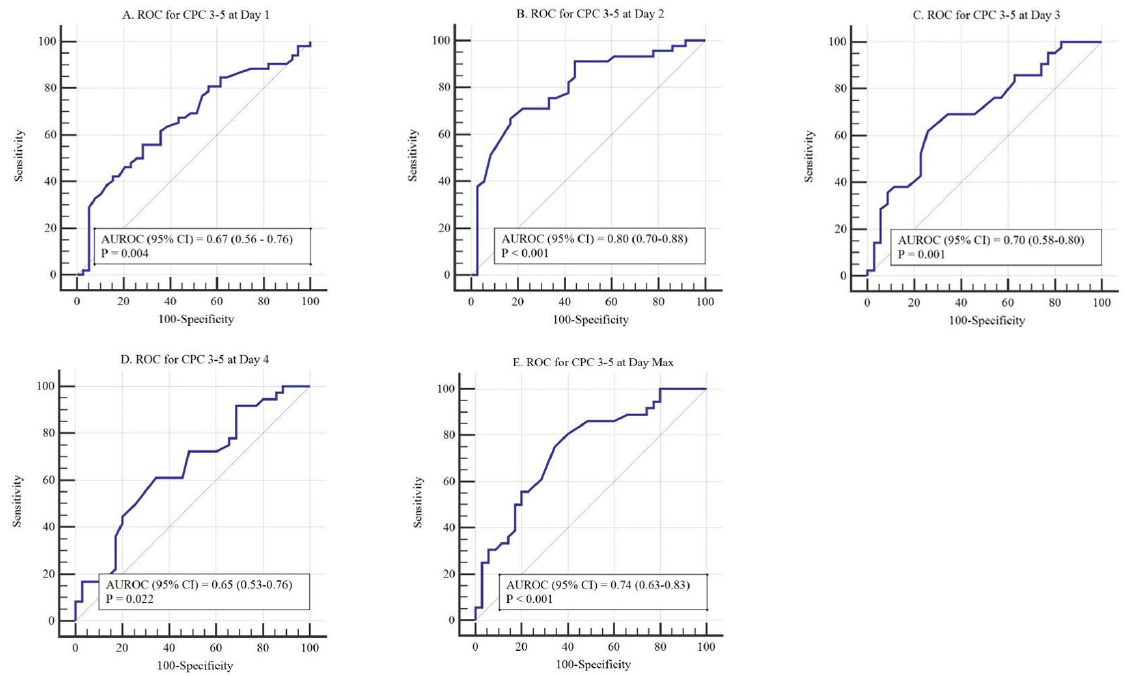
Figure 5. Area under the curves (AUC) for predicting a poor neurological outcome at different intracranial pressure (ICP) levels. ( A ) Receiver operating characteristic curve for ICP levels on day 1 (AUC 0.67, p = 0.004; cut-off value > 11.8 mmHg). ( B ) Receiver operating characteristic curve for ICP levels on day 2 (AUC 0.80, p < 0.001; cut-off value > 14.0 mmHg). ( C )